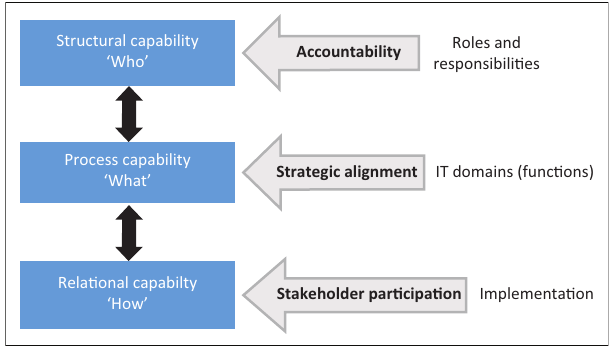
FIGURE 1: Information technology governance decision-making and implementation process